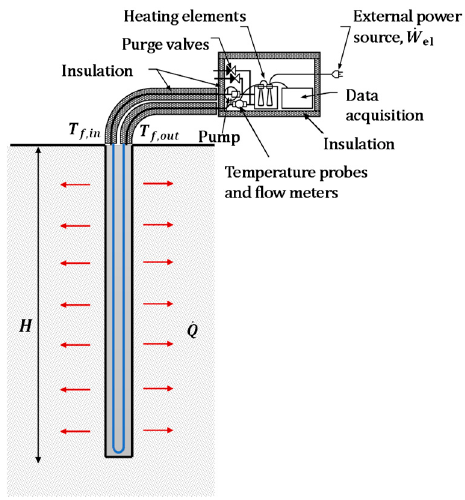
Figure 2. Typical conceptual schematization of a TRT.